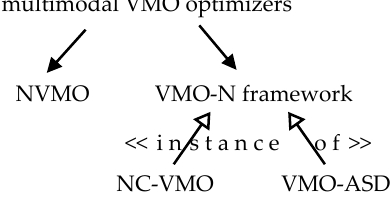
Figure 2. VMO for multimodal optimization.